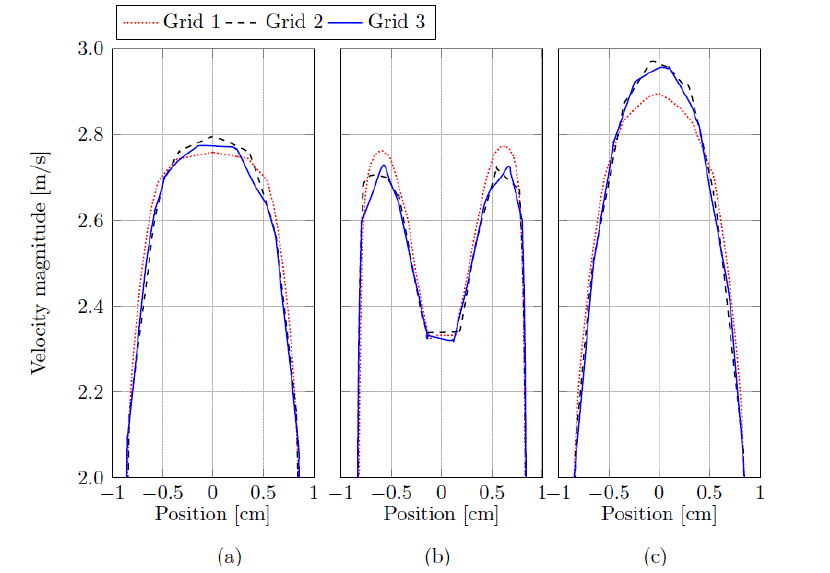
Figure 6. Velocity magnitude distribution across centerline for Grids 1–3 using water: at a distance of 0.15 m from the inlet ( a ); at 90 ◦ of section bend ( b ); and at 0.3 m from the outlet ( c